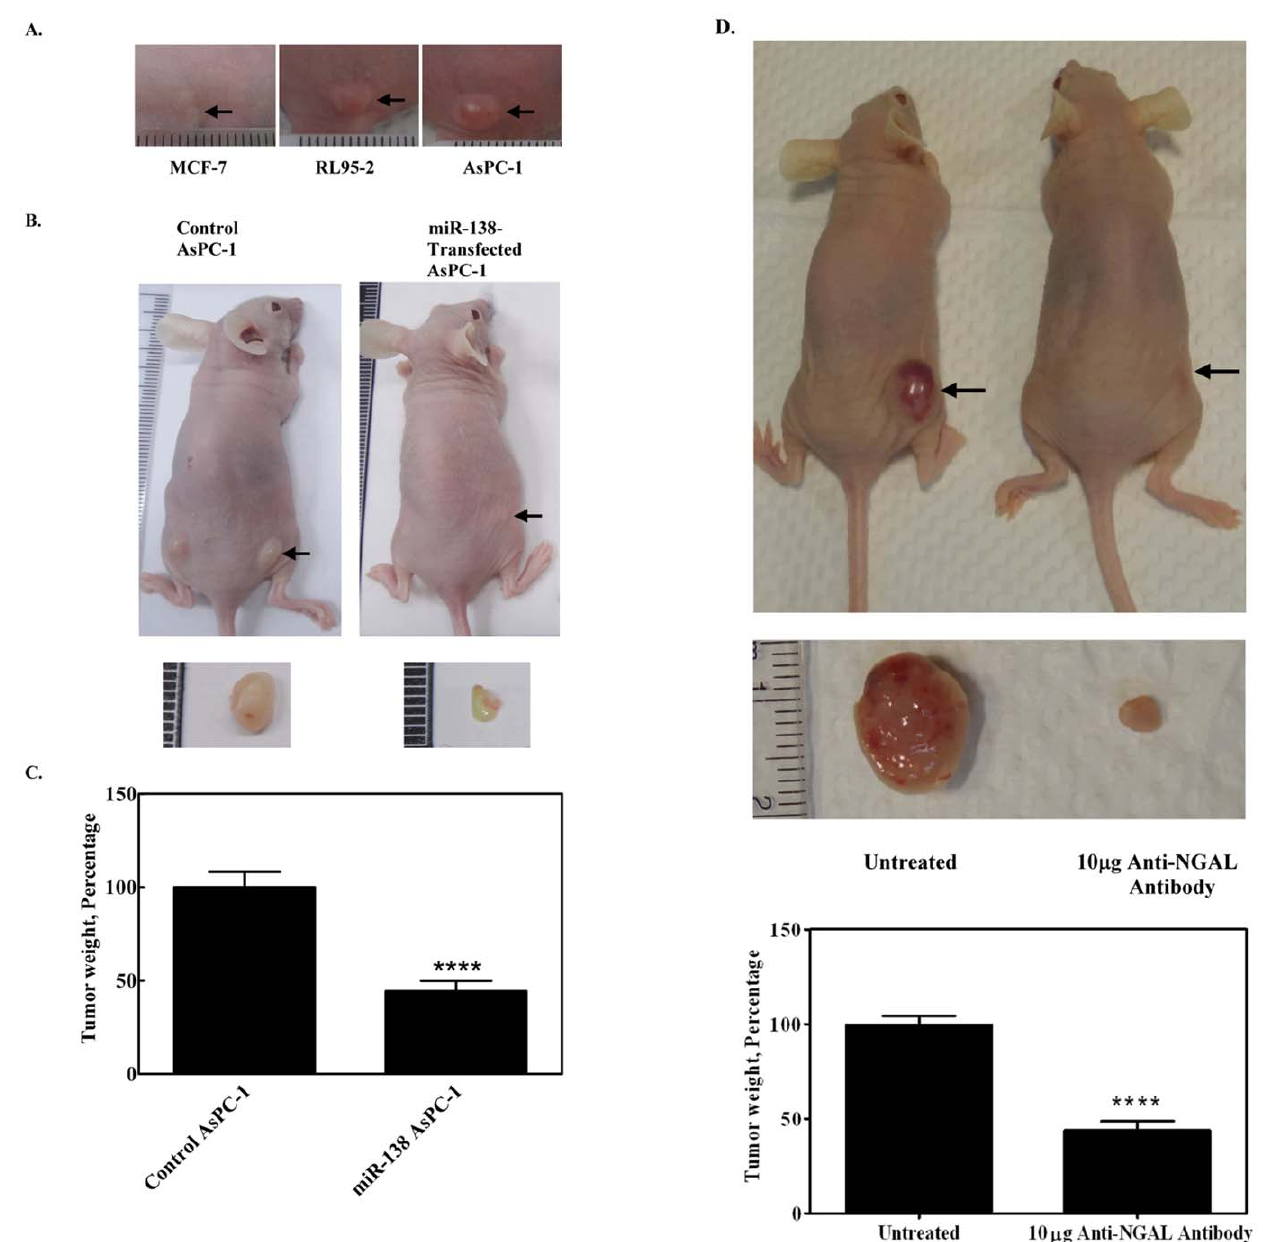
Figure 6. Invivo tumorigenicity test. (A) Tumors were formed after 30 days in nude mice after inoculation with three different cell lines (using 5 6 10 6 cells/mouse). (B) Comparison of tumorigenicity of 1 6 10 6 AsPC-1 cells stably transfected with Lentiviral-miR-138 or Lentiviral-non-targeting control in nude mice. Size of excised tumor is shown below. (C) Comparison of the tumor weight of the AsPC-1-inoculated mice 10 days after inoculation with miR-138-transfected or non-targeting control-transfected nude mice. **** indicates p , 0.0001; arrows indicate location of tumors. (D) Effect of NGAL antibody on tumorigenicity in vivo . Tumors were formed in nude mice by inoculating with 5 6 10 6 RL95-2 cells. After 14 days, NGAL antibody was injected. Typical results 30 days after the initial inoculation are shown: left, control: no antibody injected; right, NGAL antibody injected as a control. Arrows indicate position of the tumor. Size of excised tumor is shown in lower panel.